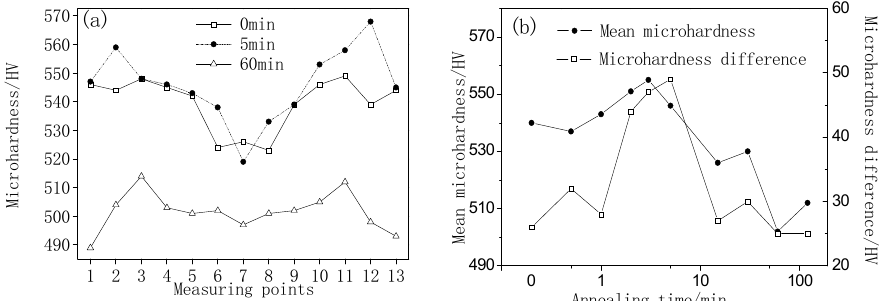
Figure 3. Microhardness of steel wires after annealing at 450 ◦ C for different time: ( a ) mean microhardness at different measuring points of wires annealed for 0, 5, and 60 min; ( b ) mean microhardness and microhardness difference of wires annealed for the entire time